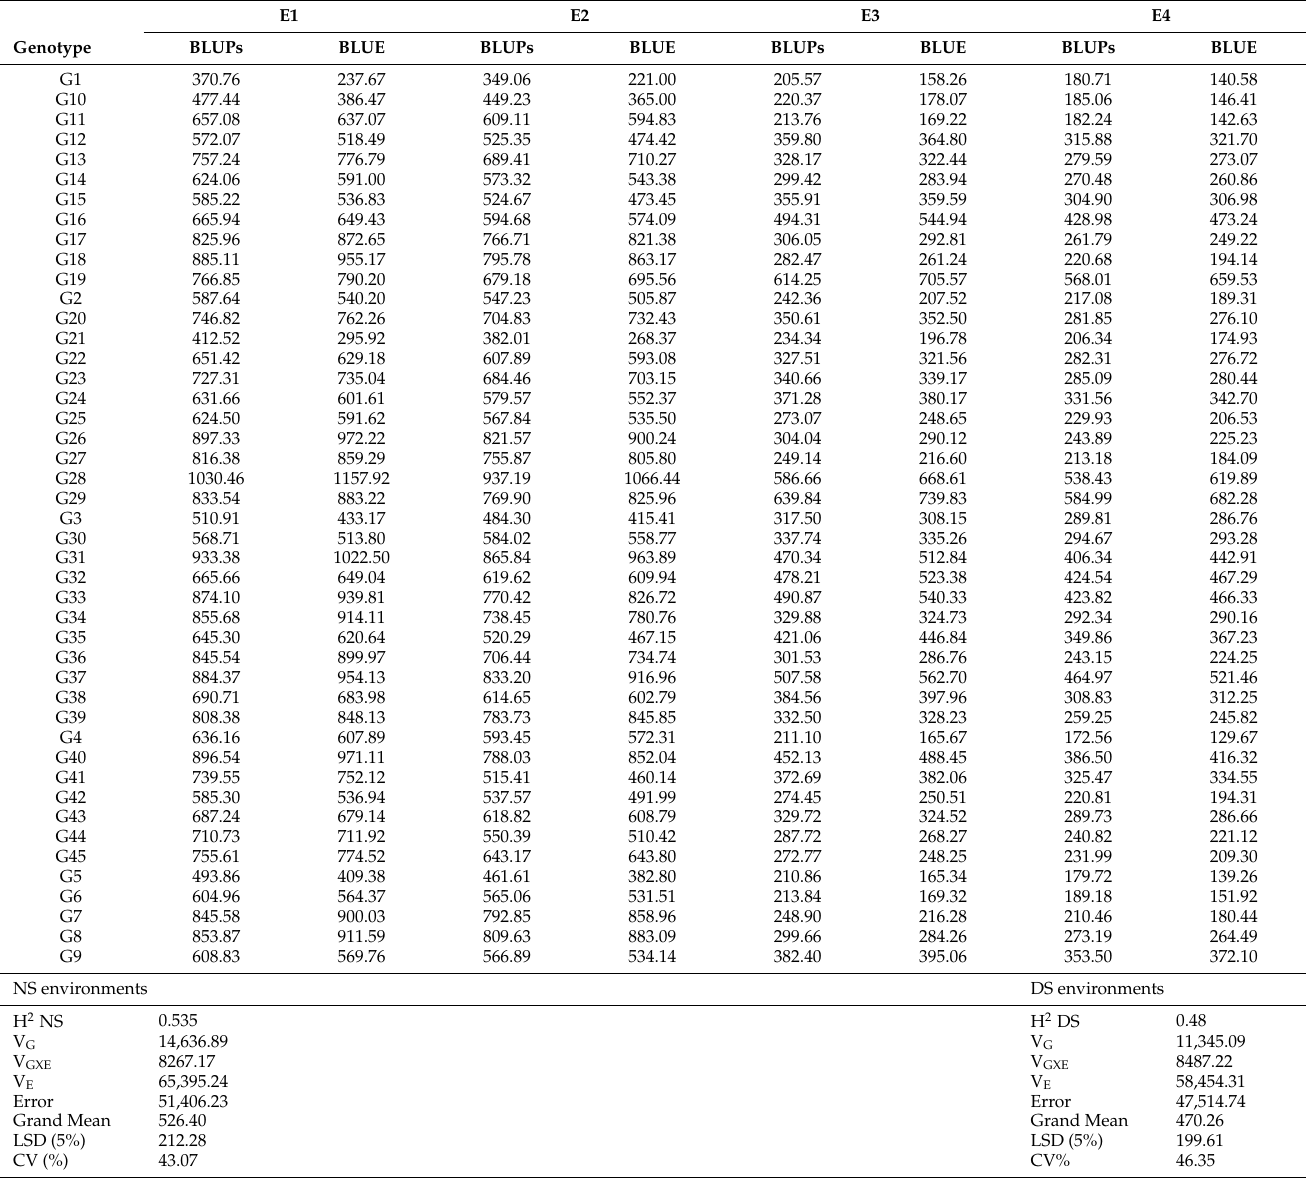
BLUPS, best linear and unbiased predictions; BLUEs, best linear and unbiased estimates; H 2 NS, broad sense heritability under non stress environment; H 2 DS, broad sense heritability under drought environment; V G , genetic variance; V GXE , genotype by environment interaction variance; VE environmental variance; LSD, least significant difference; CV, coefficient of variation; E1 = LUANAR, non-stressed; E2 = LUANAR,